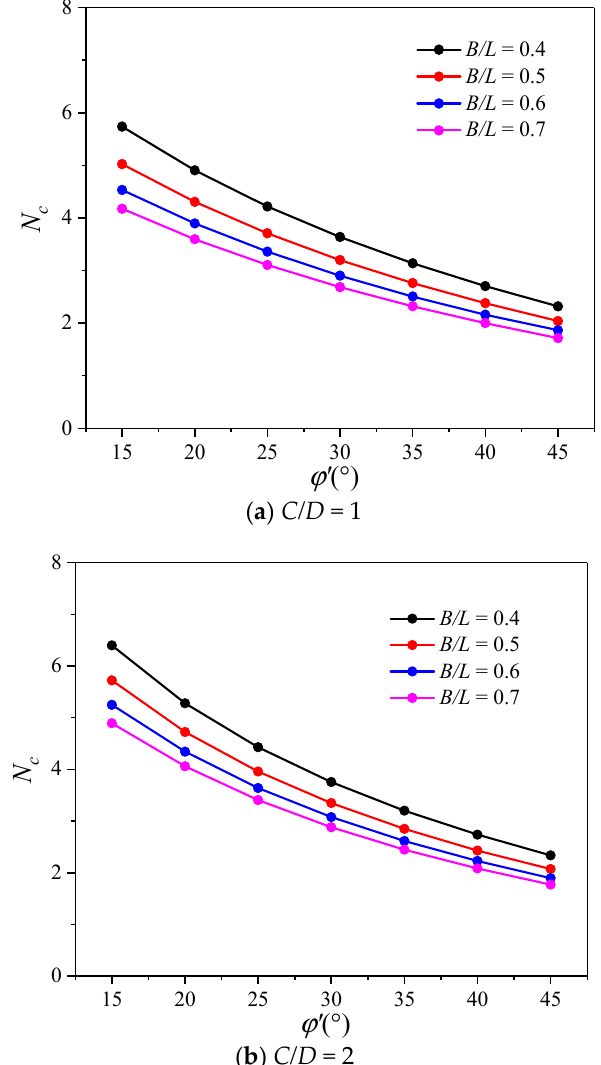
Figure 14. Variations in